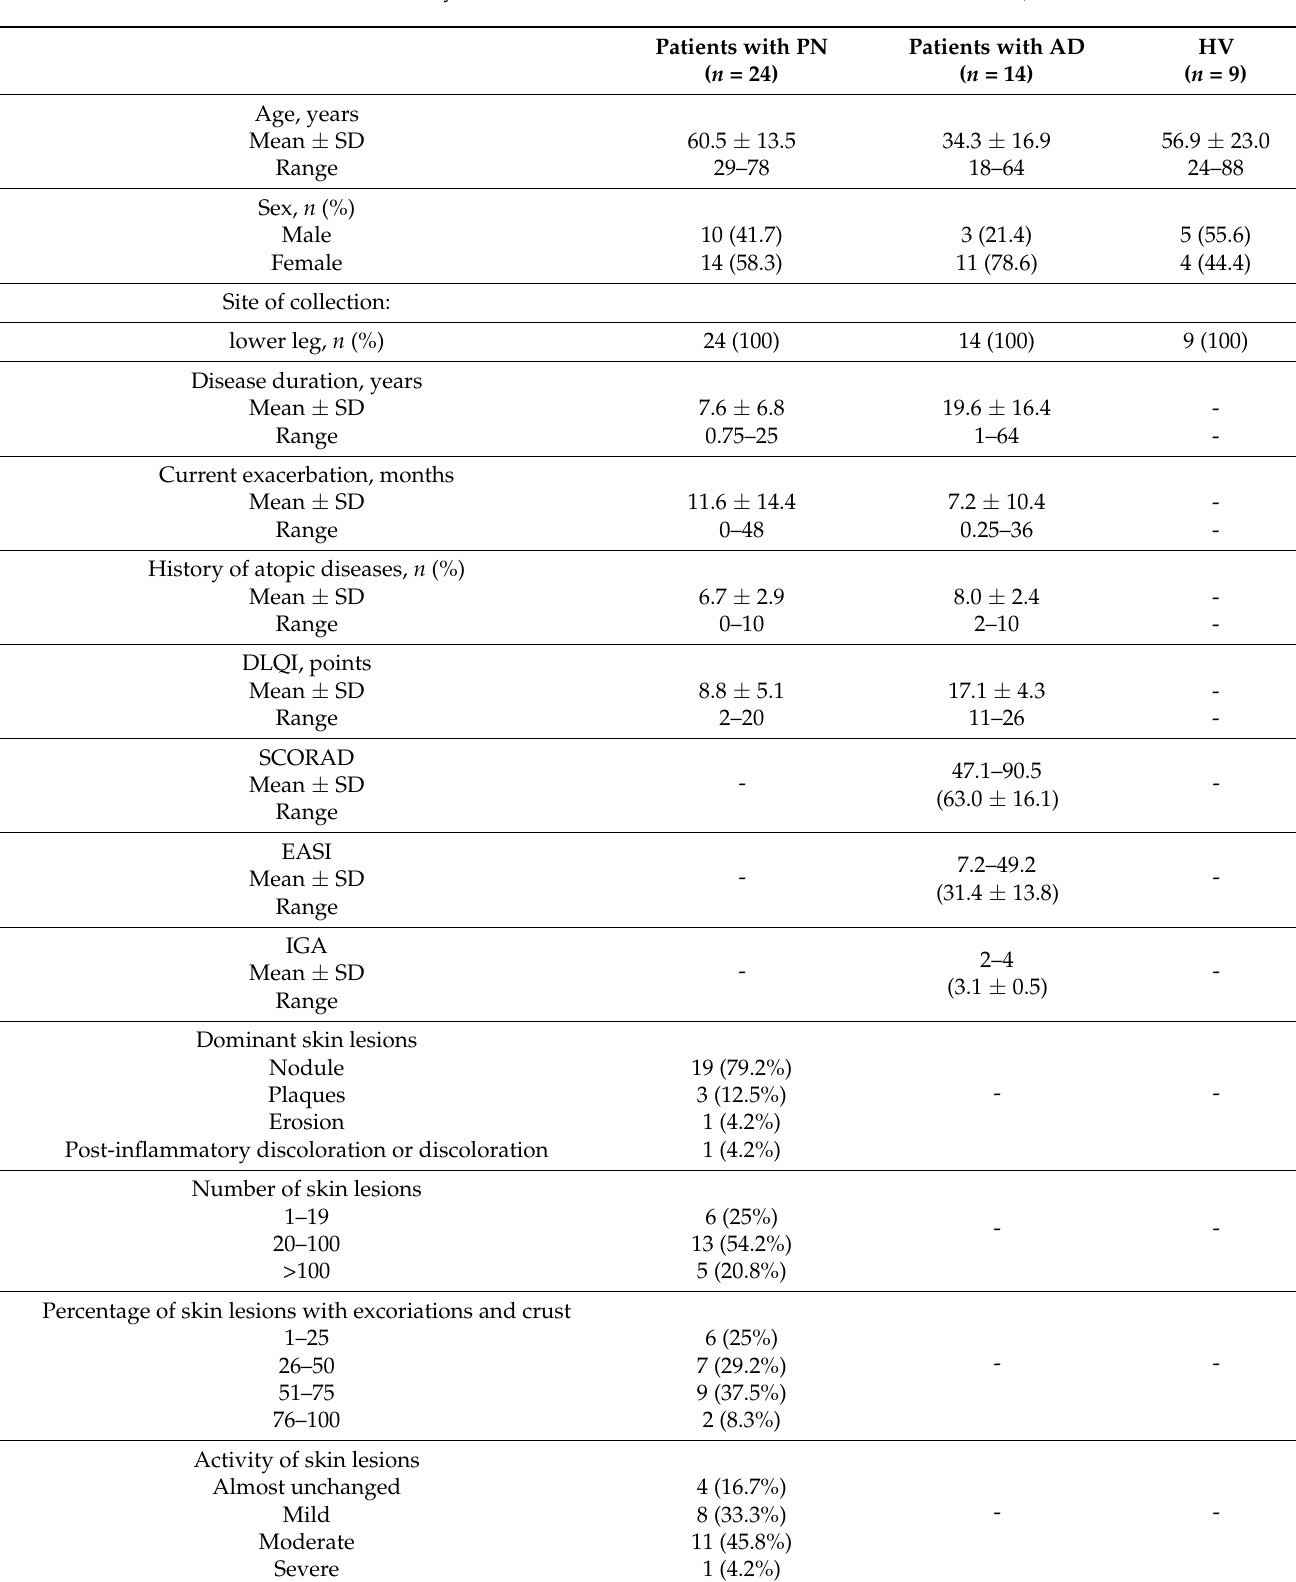
Table 1. Clinical characteristics of study participants (PN—prurigo nodularis; AD—atopic dermatitis; HV—healthy volunteers; n —number of cases; SD—standard